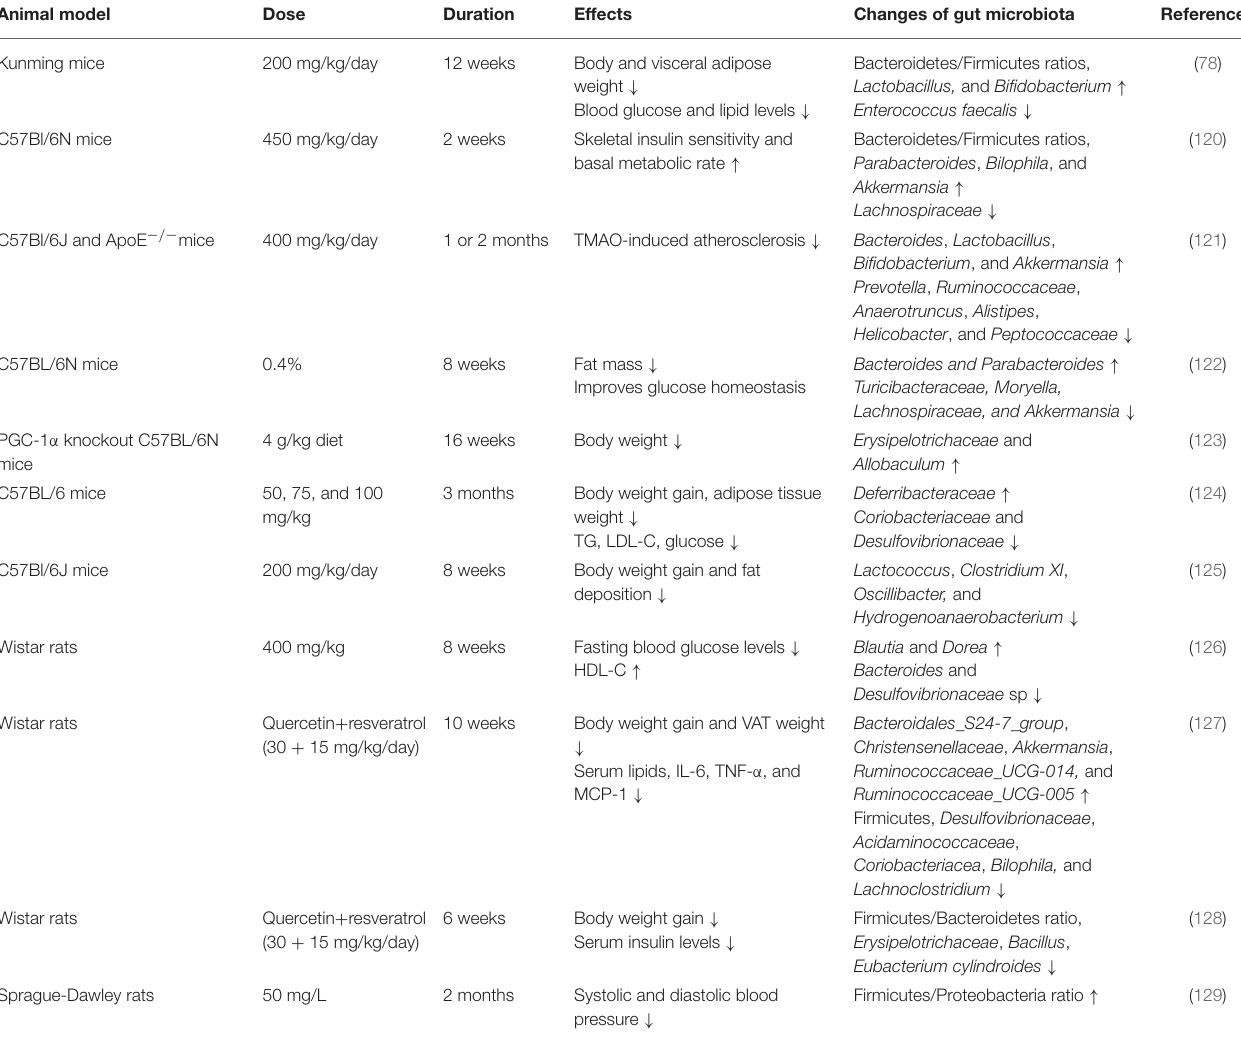
TABLE 3 | Experimental animal studies analyzing the effects of resveratrol supplementation on gut microbiota